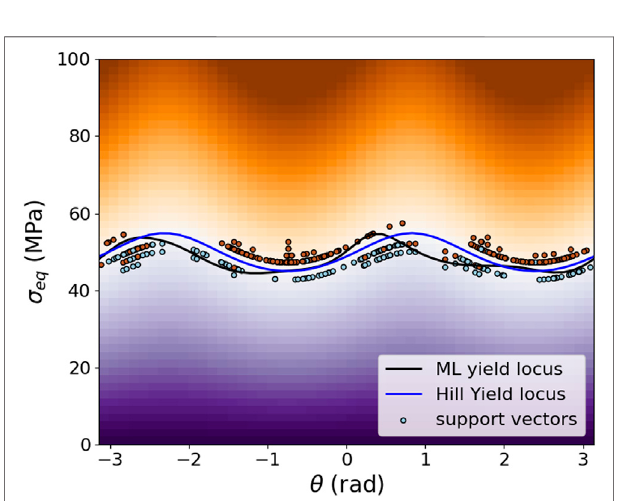
FIGURE5| TheplotoftrainedSVMclassi fi cationwithrandomlyselected training data in cylindrical coordinates on the π -plane (space of principal deviatoric stresses). The fi gure annotations are identical to Figure 4 .